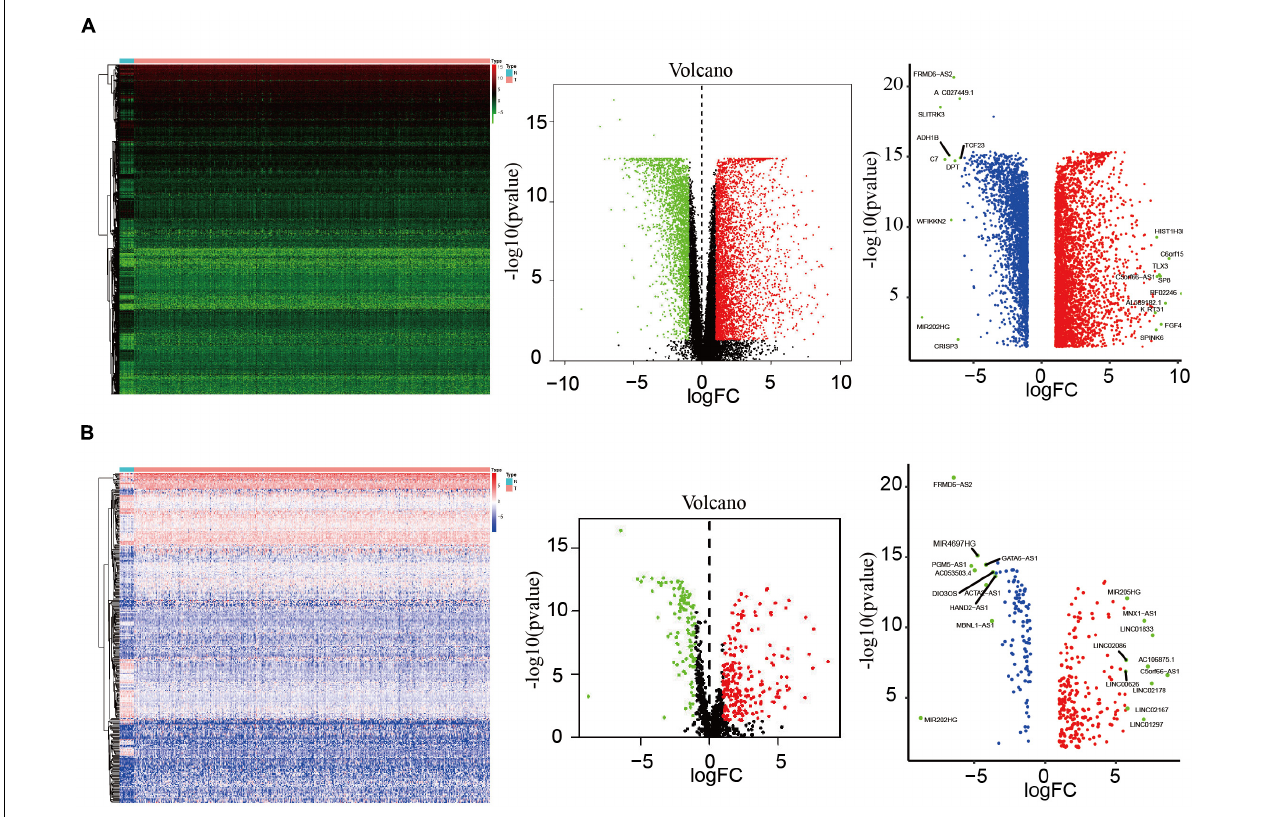
FIGURE 1 | Analysis of differentially expressed lncRNAs. (A) Heatmap and volcano map of 552 EC samples and 23 normal endometrium samples showing 3,860 upregulated molecules and 2,406 downregulated molecules (fold change > 4, p = 0.001), and showed the most differentially expressed molecules. (B) Heatmap and volcano plots of 340 differentially expressed lncRNAs showing 228 upregulated and 112 downregulated, and showed the most differentially expressed